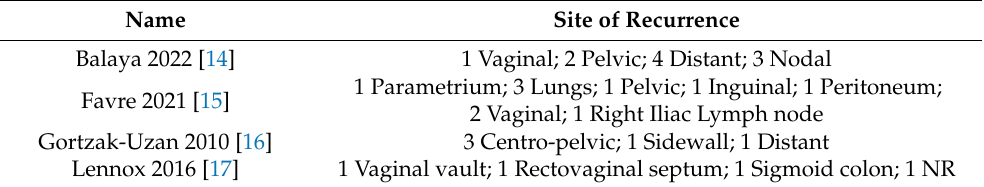
Table 5. Sentinel lymph node site of